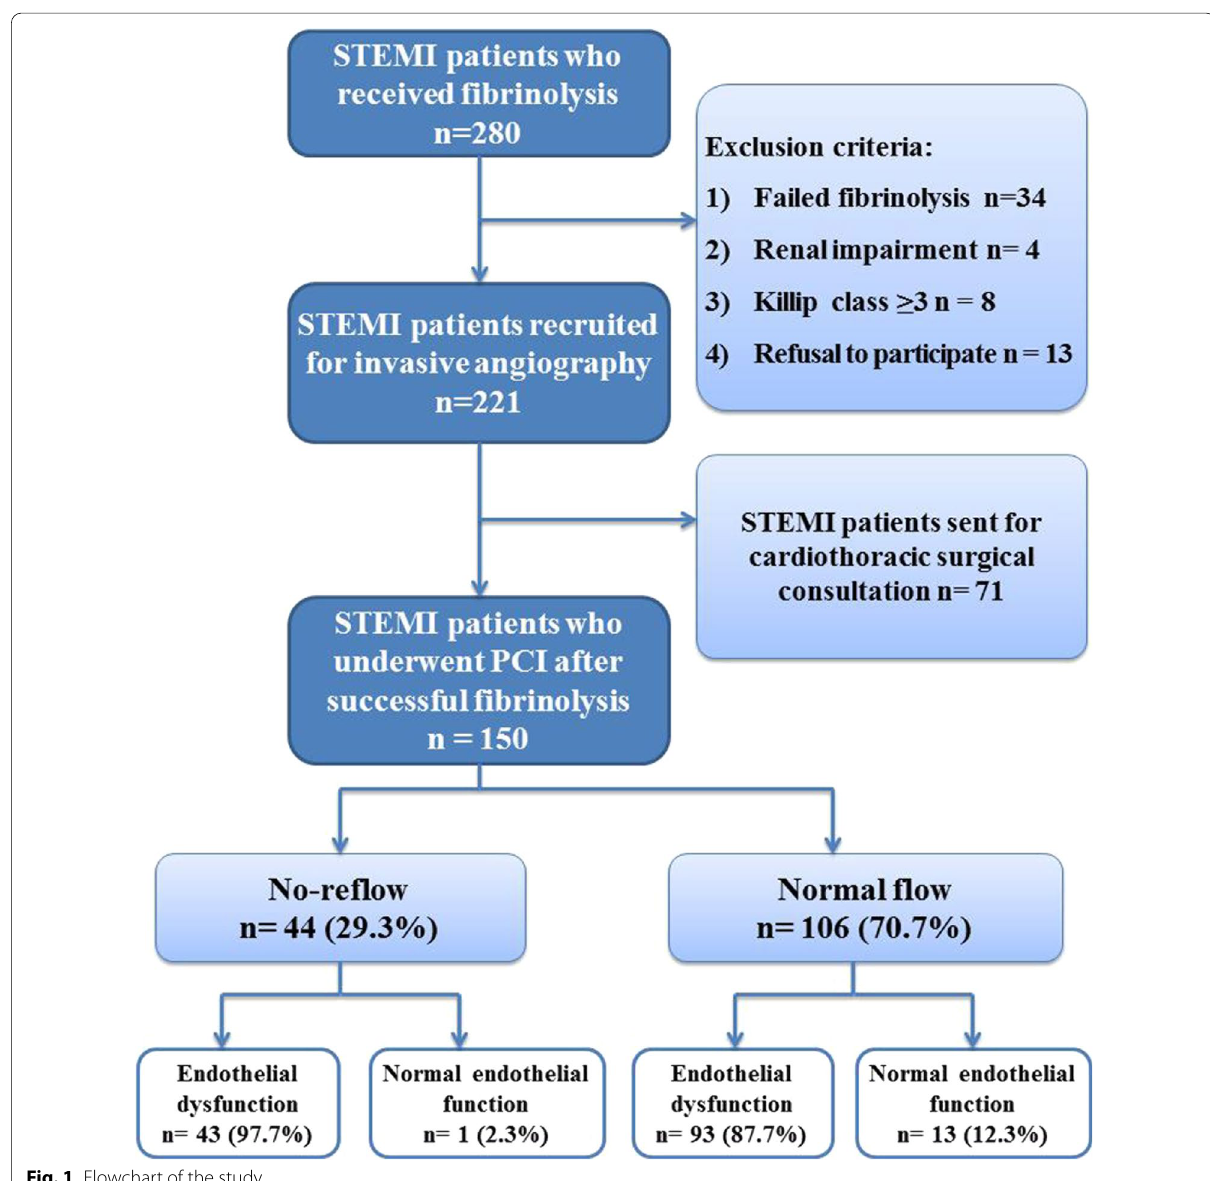
correlation between post-procedural TIMI flow and FMD ( r 0.174, p 0.033) (Fig. 2) in addition to signifi- = = cant moderate positive correlation between MBG and FMD ( r 0.366, p < 0.001) (Fig. 3). = On comparing FMD percentage between TIMI flow grades, post hoc analysis showed that the patients with TIMI I flow post-PCI had significantly lower FMD com- pared with patients with TIMI II and TIMI III flow post- PCI, and there was no significant difference between FMD values between patients with TIMI II and TIMI III flow post-PCI as shown in Table 3. Furthermore,